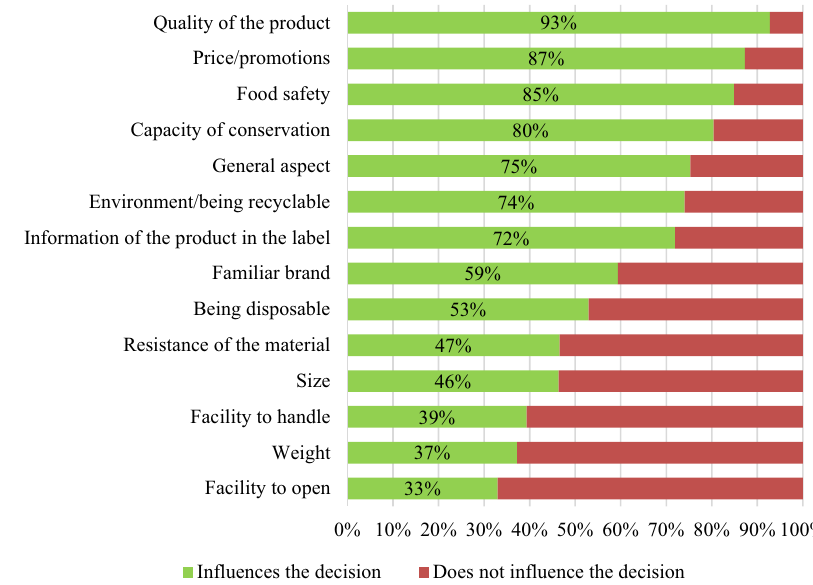
Figure 2: Characteristics of the package that in fl uence the decision to purchase a food packed in